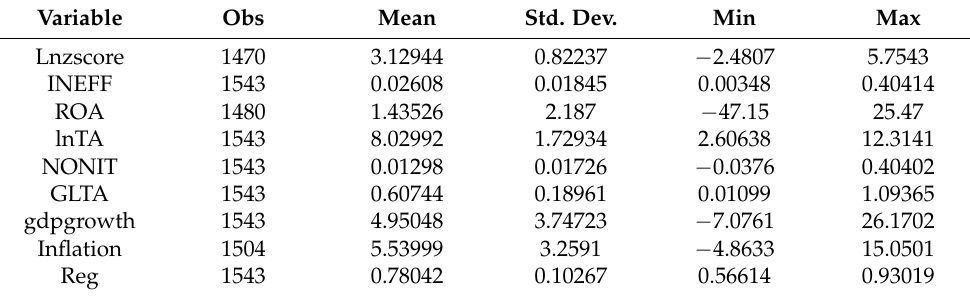
Table 4. Descriptive Statistics (Banks in Countries with French